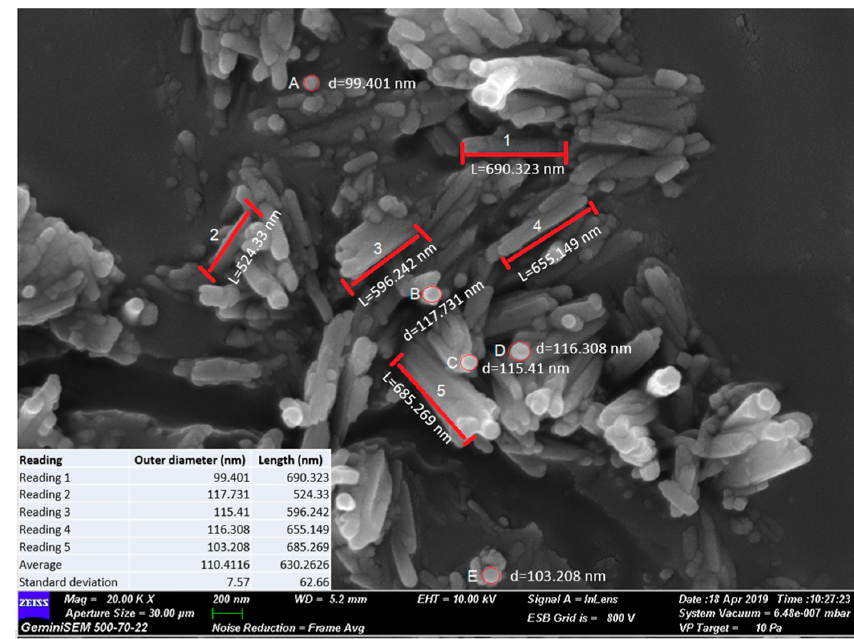
Figure 3. Field Emission Scanning Electron Microscope (FESEM) image of halloysite nano clay showing dimensions.